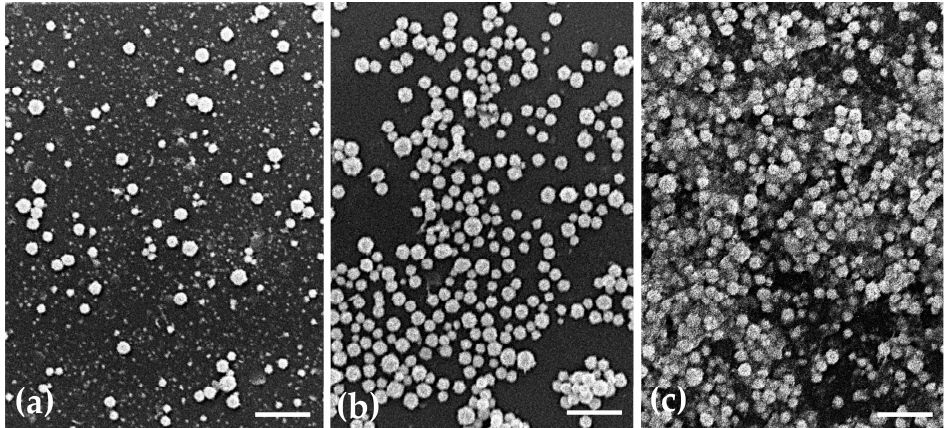
Figure 3. Representative scanning electron micrographs showing the morphology of ( a ) uncoated AuNPs, ( b ) HAOA-AuNPs (1:1) and ( c ) BSA-AuNPs (0.25:1). Scale bars = 2.5 µm.